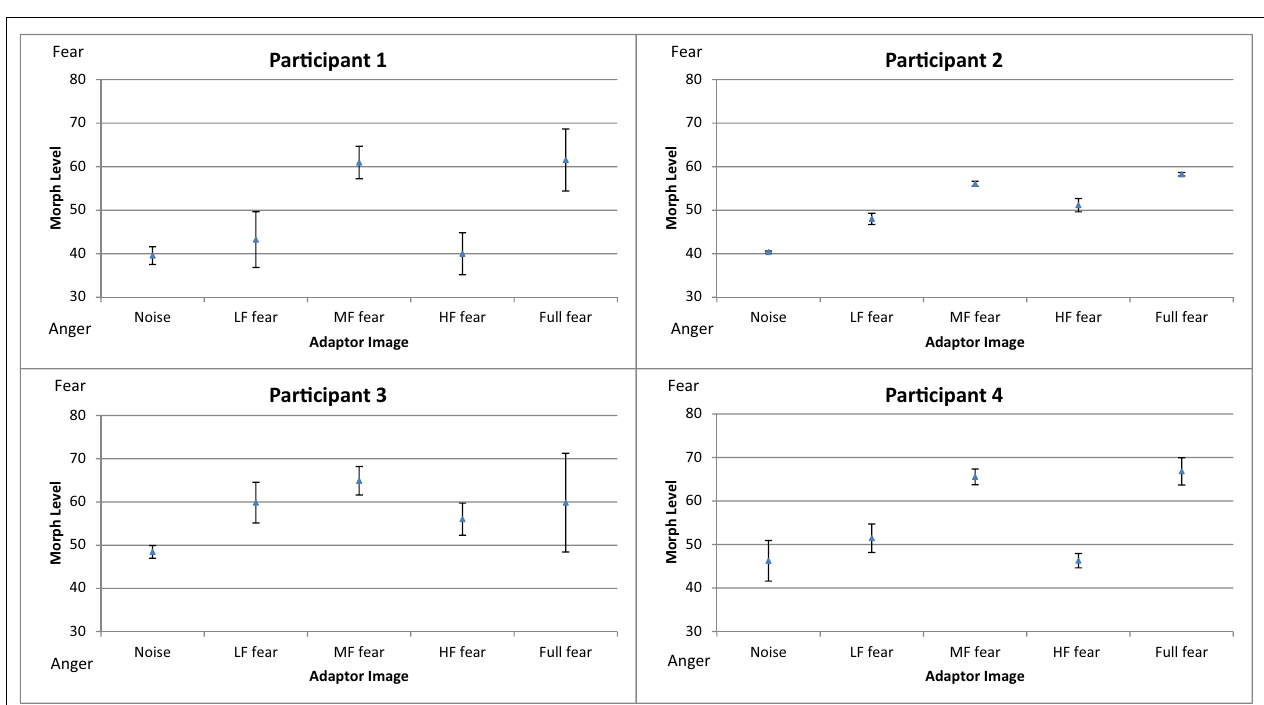
FIGURE 6 | Mean thresholds of morph level for the five conditions (white noise, LF fear, MF fear, HF fear, and full-bandwidth fear) for the participants in Experiment 3 . Error bars show ± 1 standard error of the mean.